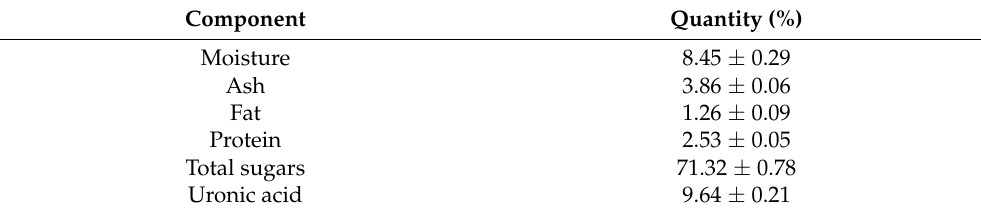
Table 2. Chemical composition of purified PAG.